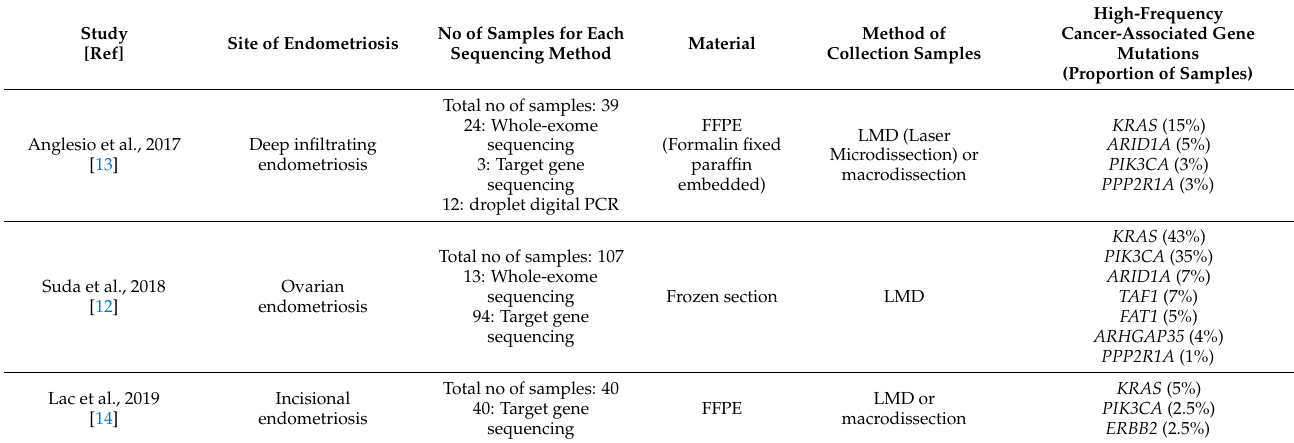
Table 3. Summary of genomic alterations in